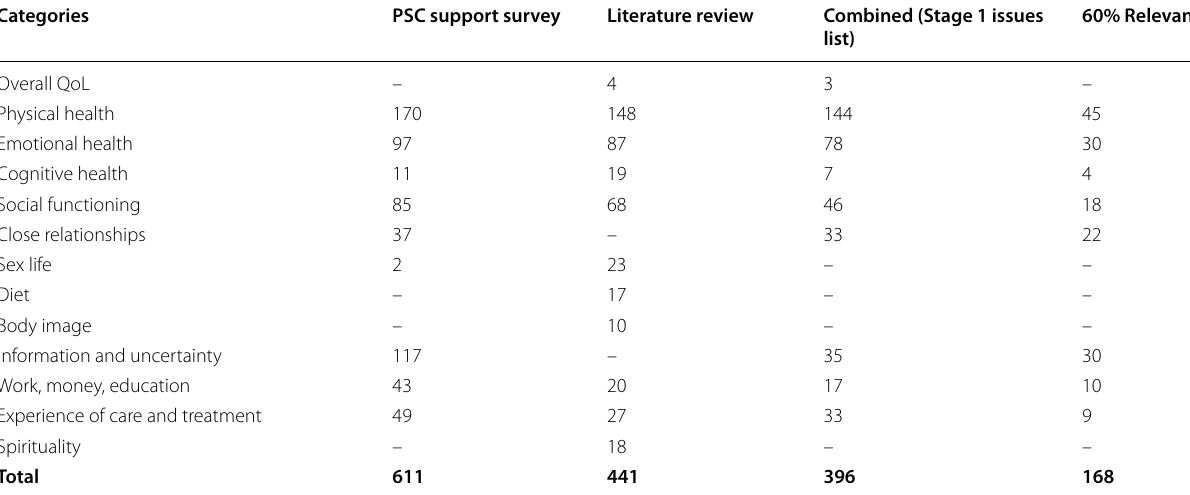
Table 4 Number of issues by category for each step in the